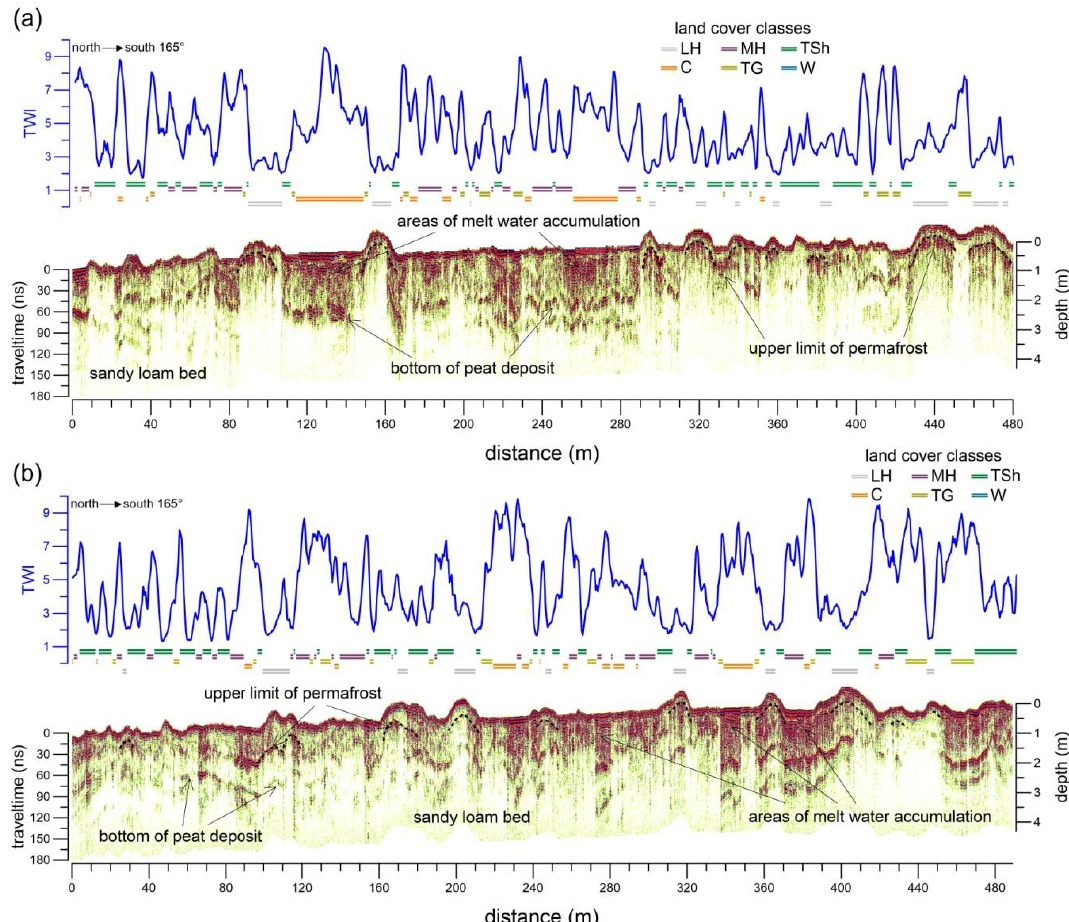
Figure 9. GPR cross-section, graph of TWI and LCC intervals from profiles GPR 4 ( a ) and GPR 5 ( b ); dashed lines delineate permafrost table.